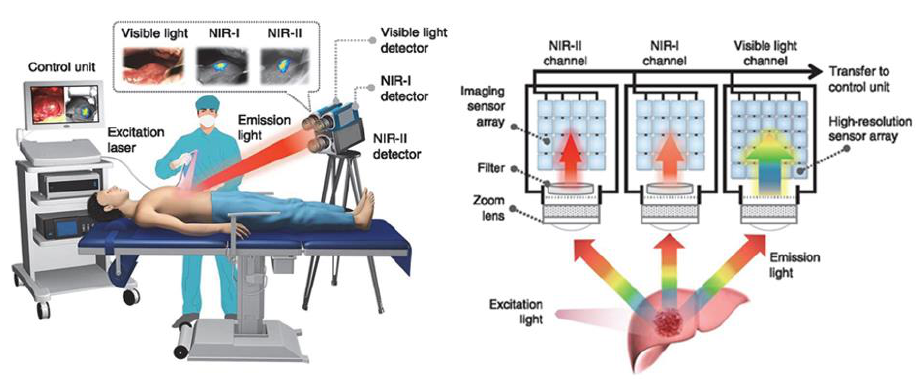
Figure 1. The illustration of multiple wavelengths for fluorescence surgical navigation [2].